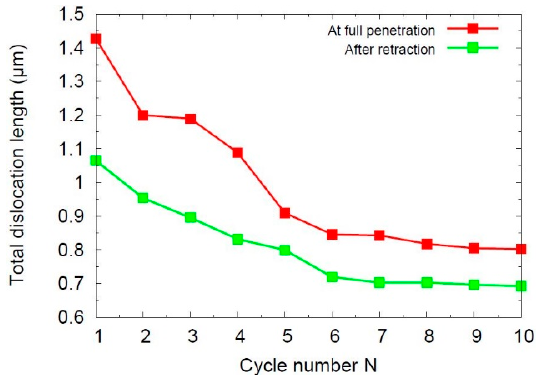
Figure 8. Dependence of the total dislocation length during cyclic indentation at full penetration and after the retraction of the indenter on cycle number.